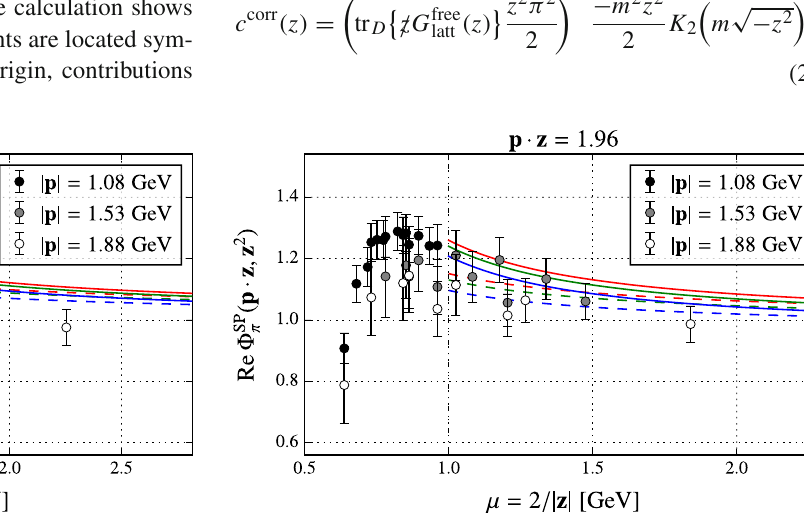
to predictions taking into account/neglecting higher twist contributions for the different DA models (6). The color-coding is the same as in Fig.